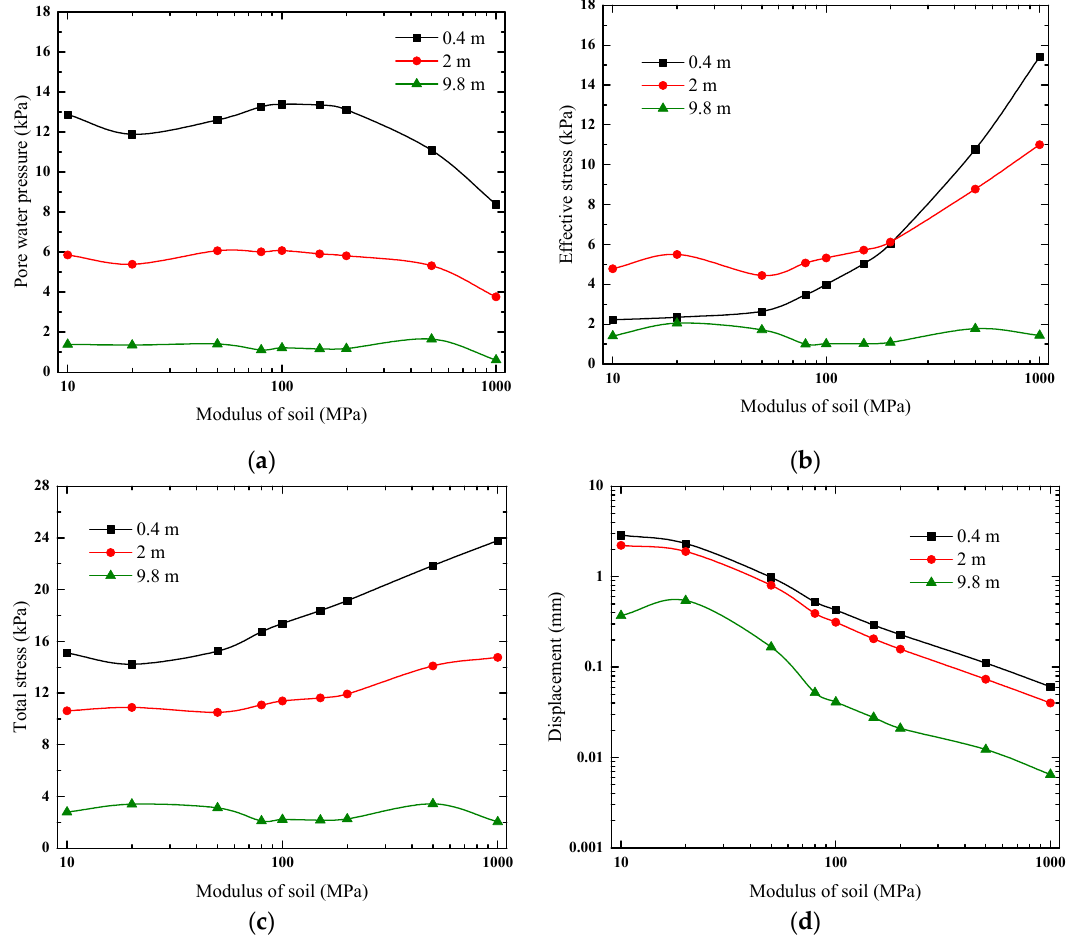
Figure 10. Vibration responses with soil modulus: ( a ) Pore water pressure, ( b ) effective stress, ( c ) total stress, and ( d ) displacement.